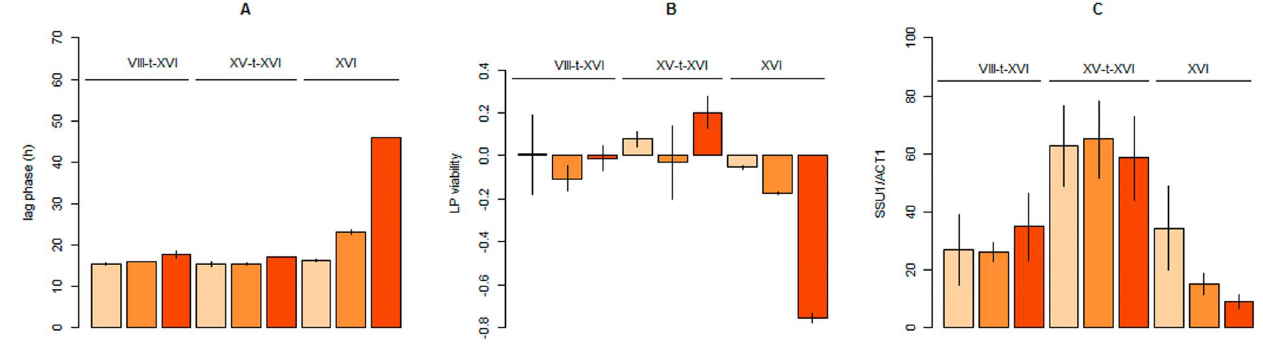
Figure 3. Effect of translocations XV-t-XVI and VIII-t-XVI on lag phase, LP viability and SSU1 expression. The lag phase, LP viability, and expression level of SSU1 gene are shown in panel A, B and C, respectively. Data were obtained from alcoholic fermentation using the strains F10, GN and SB carrying the chromosome forms VIII-t-XVI, XV-t-XVI and nt-XVI, respectively. For each strain, fermentations were carried out in synthetic media containing increasing concentrations of total SO 2 (0, 20 and 40 mg), graphically represented by orange scale 0 mg=light orange, 20 mg=orange, 40 mg=dark orange. For panel A and B, bar plots represent the mean with standard error of three independent repetitions. For panel C the expression level of SSU1 was normalized by ACT1 . Data represent the mean and standard error of 6 to 9 samples collected during the lag phase.